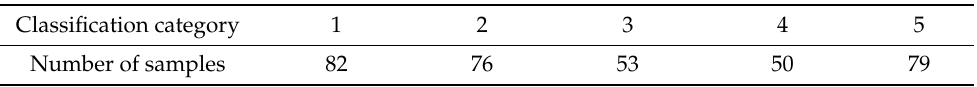
Table 2. Clustering result, the first row represents categories, and the second row represents the number of similar categories.